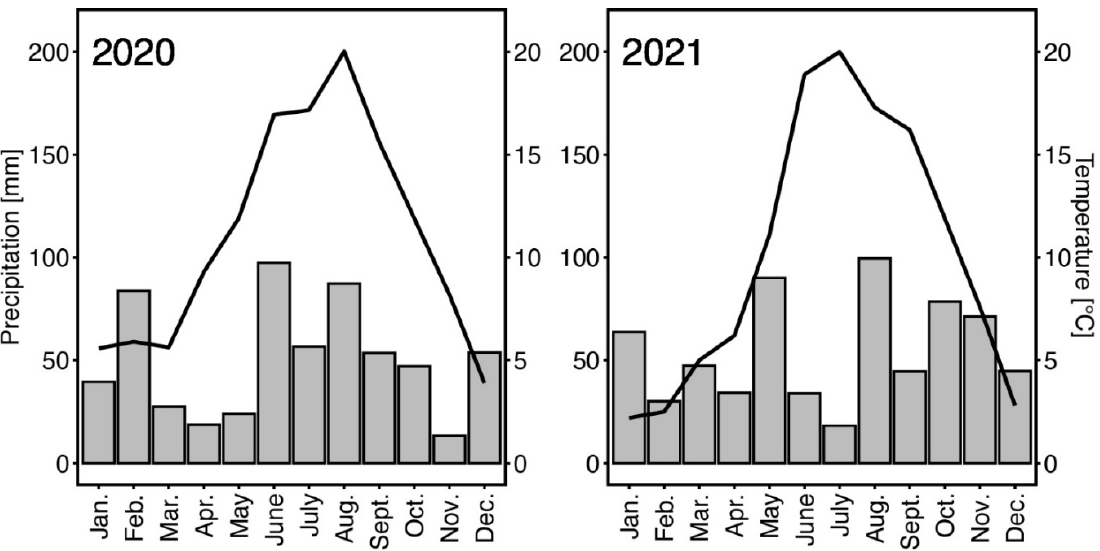
Figure 1. Average monthly precipitation (mm, shown as bars) and average monthly temperature (°C, shown as lines) in 2020 and 2021. shown as lines) in 2020 and